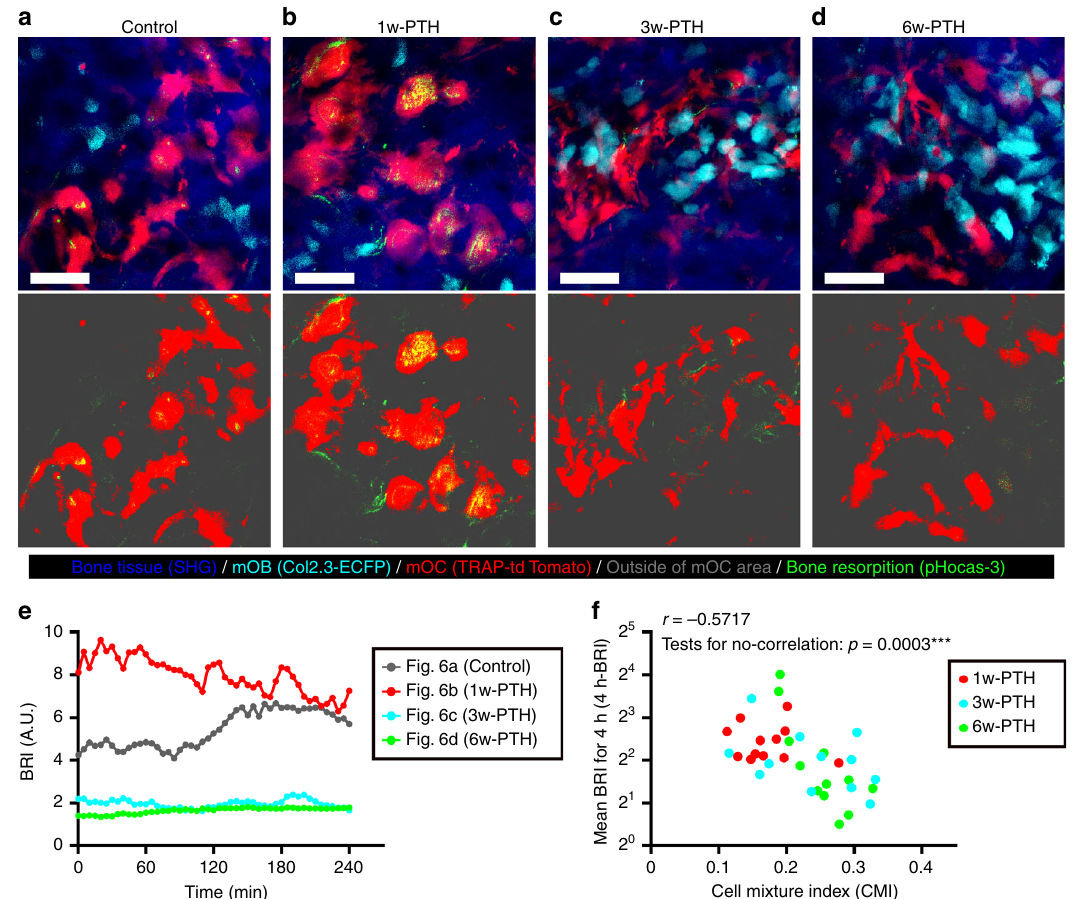
Fig. 6 Direct contact attenuates resorbing activity in PTH-treated bone. a – d Representative MIP images of the bone-resorptive activities of control and 1-w- , 3-w-, and 6-w-PTH-treated Col2.3-ECFP/TRAP-tdTomato mice using a pH-sensing chemical probe, pHocas-3. The binarized mOC areas and the pHocas- 3 signals are indicated in the bottom panels. Green, fl uorescent signals from pHocas-3; Cyan, mOBs expressing Col2.3-ECFP; red, mOCs expressing TRAP- tdTomato; blue, bone tissues (SHG). Scale bar, 50 µ m. e BRI time courses for the visual fi elds shown in a – d . f Correlations between CMI and the mean BRI values over 4 h; n = 12, collected from 8 to 10 mice per group. Data are presented as means ± SDs. *** p < 0.001 (Spearman ’ s correlation coef fi cient, r = − 0.5717; tests for no correlation, p =